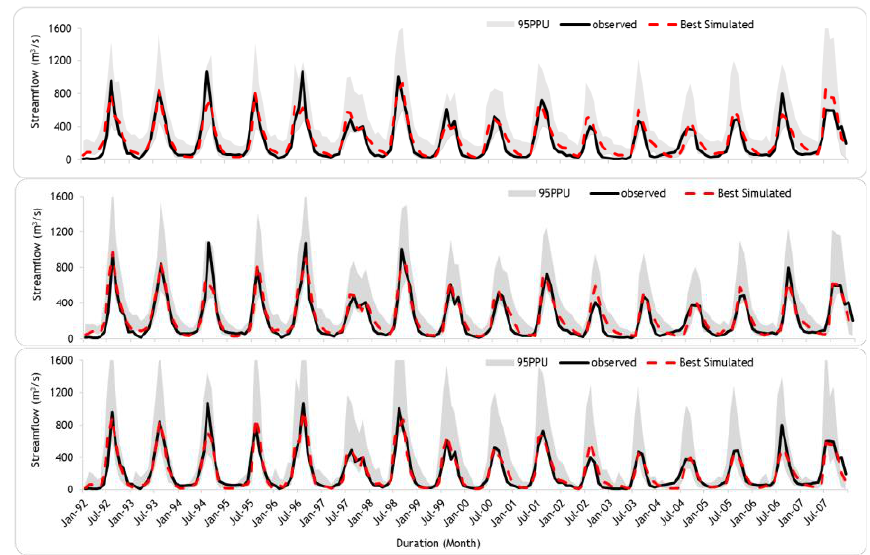
Figure 8. Top-down orientation of observed and best-simulated flows with their 95% confidence level of the subbasin segmentations of 4, 8, and 30, respectively, at the Abelti watershed.